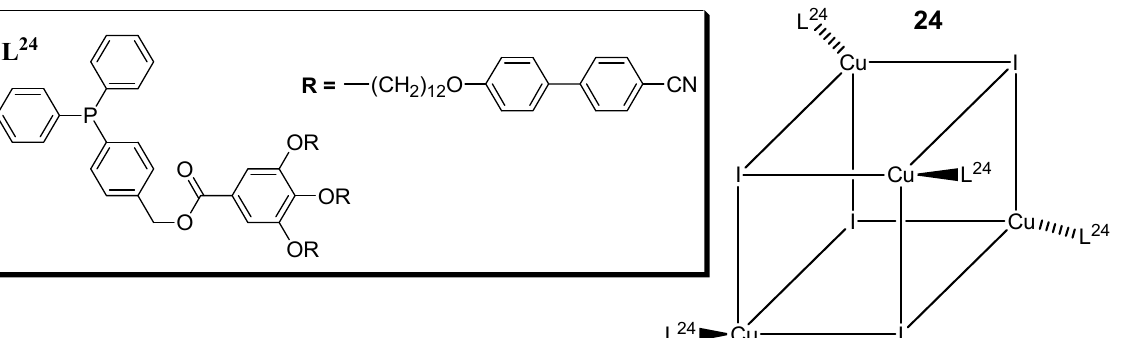
Figure 10. General structure of the functionalized [Cu 4 I 4 (L 24 ) 4 ] copper iodide clusters with phosphine ligands [59].